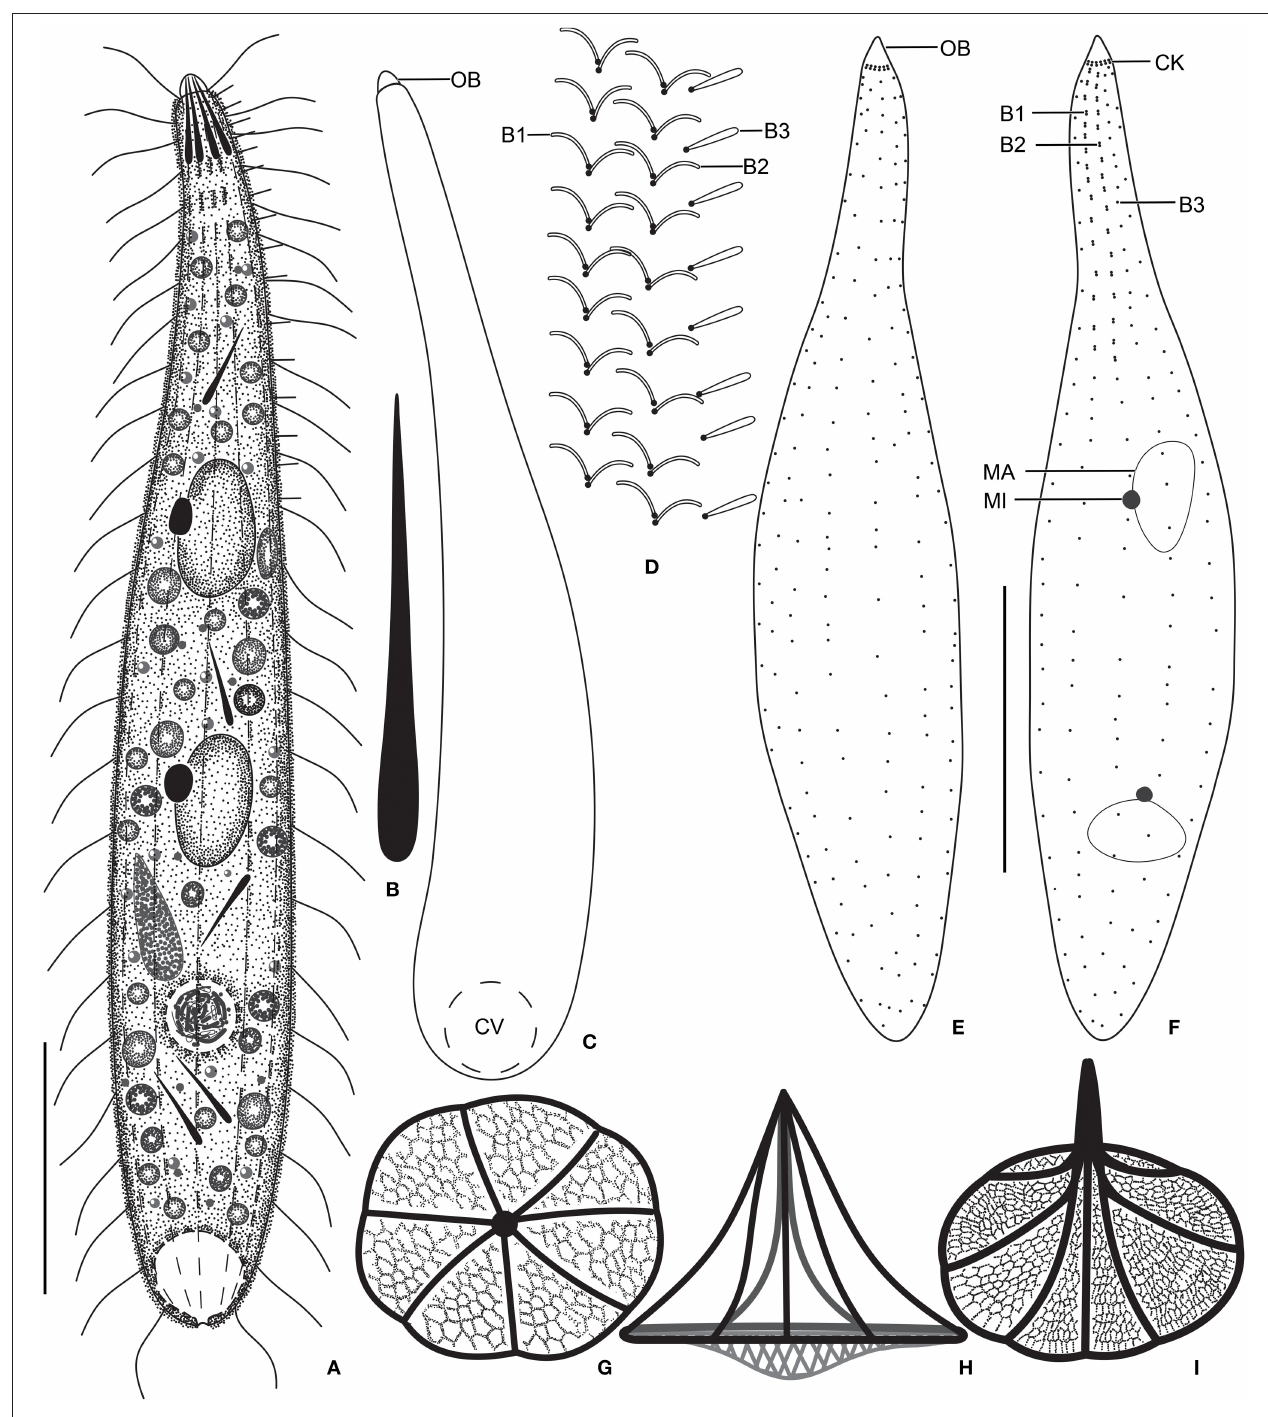
FIGURE 1 | Monolamellophrya terricola gen. nov., sp. nov. from life (A–D) , after protargol impregnation (E,F) , and redrawn from scanning electron micrographs (G–I) . (A) A representative specimen, showing the body shape and the acicular extrusomes in the oral region and cytoplasm. (B) Acicular extrusome. (C) A specimen with broadly rounded posterior end. (D) Ciliature of dorsal brush. (E,F) Ventral (E) and dorsal (F) views of the holotype specimen, showing the infraciliature and the nuclear apparatus. (G–I) Vertical (G) , lateral (H), and oblique distal (I) views of the type II lepidosomes, showing the circular baseplate with convex middle portion, the fine arcs forming rosette-like structure in surface view (G), and a conspicuous cone structure in lateral view (H) . B1–3, dorsal brush rows; CK, circumoral kinety; CV, contractile vacuole; MA, macronucleus; MI, micronucleus. Scale bars = 30 µ m.